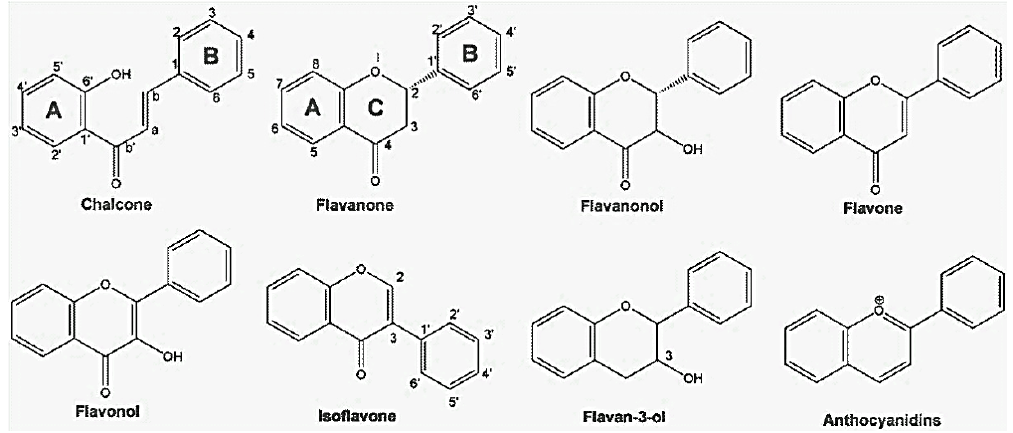
Figure 1. Classification of flavonoids based on their chemical